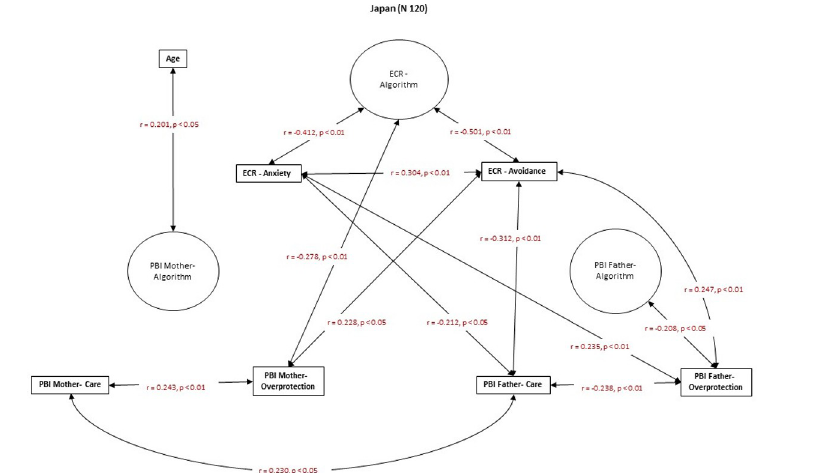
Fig 4. Spearman’s r correlations between ECR and PBI in the Japanese group.